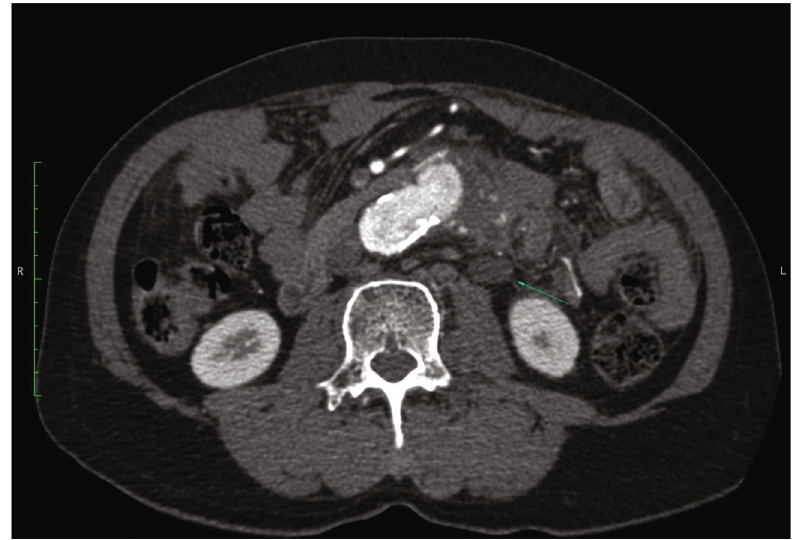
Figure 3: This slide showed the left hydronephrosis (arrow